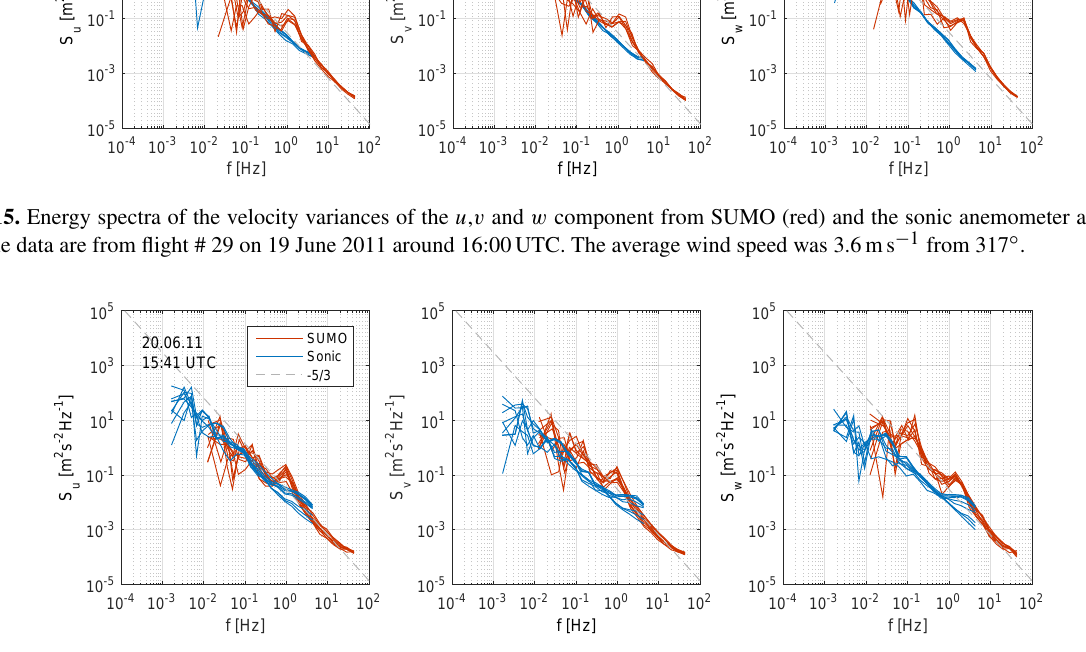
Figure 16. Energy spectra of the velocity variances of the u , v and w component from SUMO (red) and the sonic anemometer at the 60m mast. The data are from flight # 31 on 20 June 2011 around 16:00UTC. The average wind speed was 2.7ms − 1 from 53 ◦